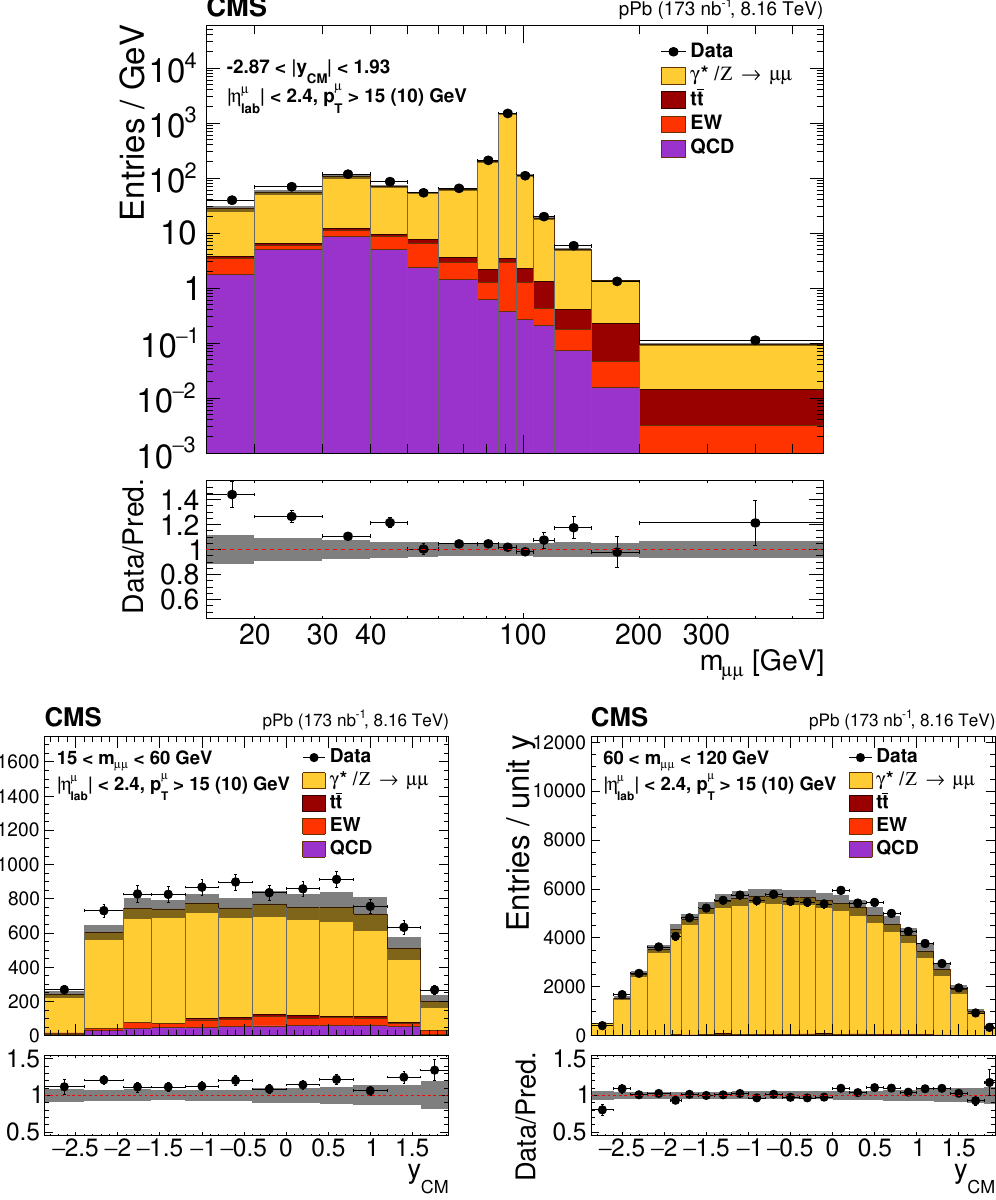
Figure 1 . Comparison of the data (black points) with the Z / g ∗ signal and background expectations (filled histograms, where “EW” includes Z / g ∗ → t + t − and diboson), estimated as described in the text, as a function of invariant mass (upper) and rapidity in the centre-of-mass frame for 15 < m < 60 GeV (lower left) and 60 < m < 120 GeV (lower right). Vertical error bars represent mm mm statistical uncertainties. The ratios of data over expectations are shown in the lower panels. The boson p reweighting described in the text is not applied. The shaded regions show the quadratic T sum of the systematic uncertainties (including the integrated luminosity, but excluding acceptance and unfolding uncertainties) and the nPDF uncertainties